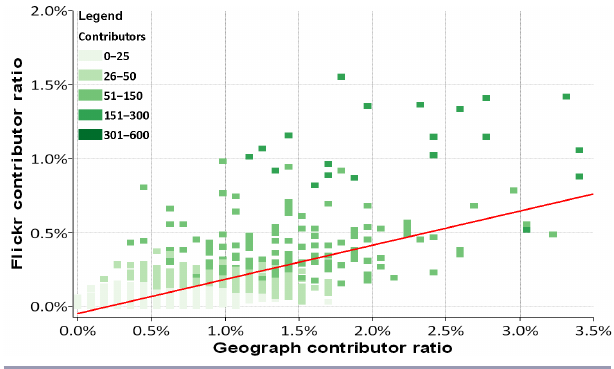
Fig. 5. Comparison of the numbers of contributors to Geograph and Flickr for nonurban grid